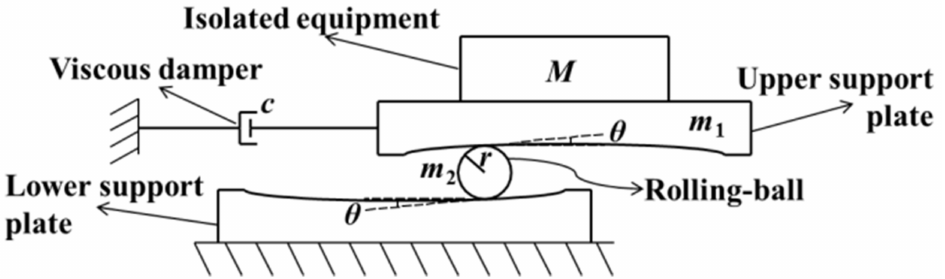
Figure 2. Analytical model for the